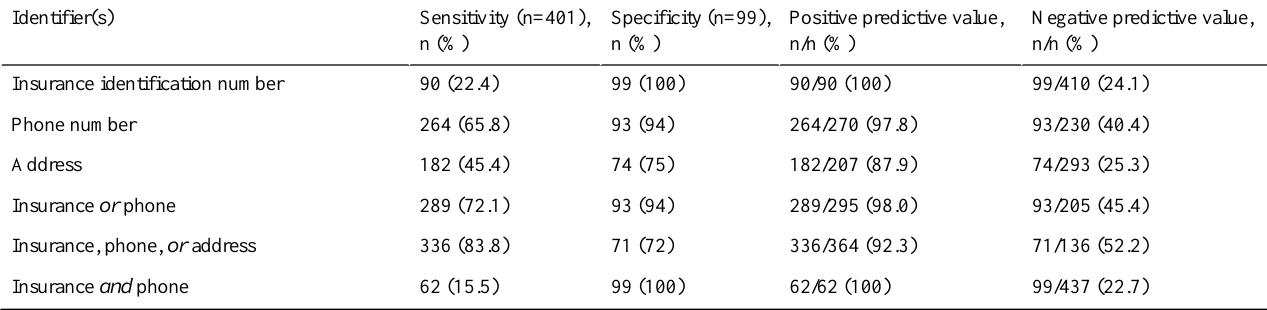
Table 2. Test characteristics of individual identifiers and combinations compared with verification of child-mother linkage by manual chart